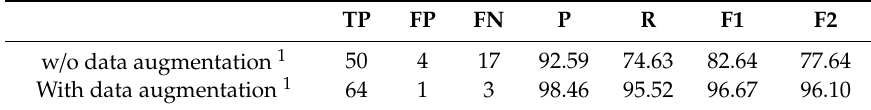
Table 8. Results with and without data augmentation on Mayo Clinic WCE polyp data.